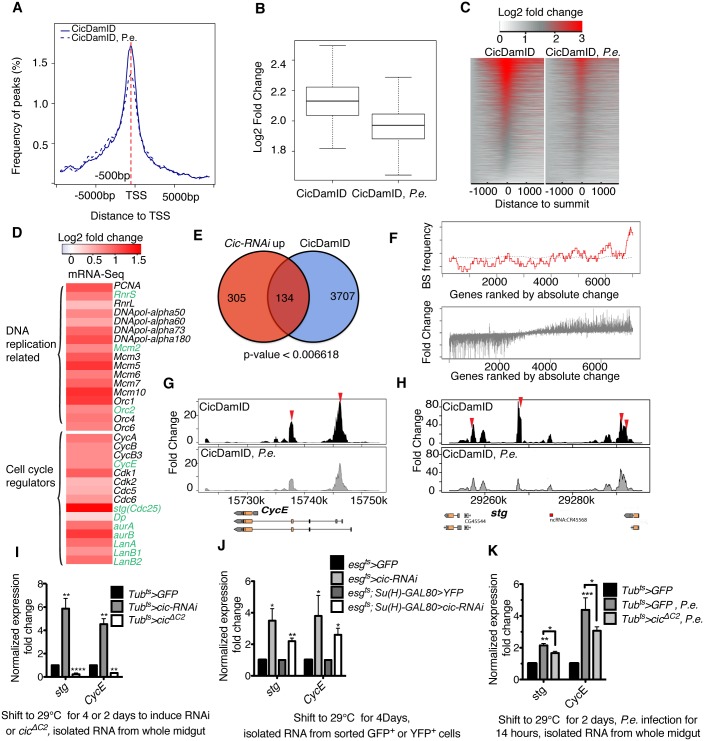
Cic targets genes in ISCs found by DamID-Seq.(A) Graph showing the location of Cic binding relative to annotated transcript TSSs. The distance is from the summit of the Cic peaks to the nearest TSS. Dashed red line showed the summit of the graph is 500bp away from TSS. (B) Box plot showing fold change of peaks in CicDamID and P.e. infected CicDam. (C) Heatmap showing fold enrichment of Cic peaks from Cic DamID-Seq without or with P.e. infection. Y axis represents genes associated with the Cic binding peaks. (D) Expression heatmap of cell cycle regulators and DNA replication related genes from RNA-Seq data from cic-RNAi expressing FACS sorted progenitor cells. The names of the genes that had Cic binding sites by DamID are written in green. (E) Venn diagram showing the overlap between genes upregulated > 1.5 fold upon cic-RNAi (left) and genes associated with Cic binding peaks (right) in ISC/EBs. (F) Graph showing correlation between genes upregulated in Cic-depleted progenitor cells, and the Cic-DamID peaks that changed significantly upon P.e. infection (upper panel). Lower panel show genes ranked by absolute expression change, and then plotted for expression fold change (bottom). (G, H) Cic binding sites in the CycE and stg loci, as determined by Cic DamID-Seq in ISC/EBs from control (above) and P.e. infected (below) midguts. Vertical bars represent the log2 ratio of the Dam-fusion signal to the Dam-only signal. Red arrows indicate TGAATG(G/A)A motifs. (I-K) mRNA level fold changes of stg and CycE analyzed by qRT-PCR and normalized to β-Tub and Rp49. (I) stg and CycE fold enrichment from whole midguts after knocking down or over expressing cic in all cells using the tub
ts
(tubGal4; tubGal80ts) driver. Transcription of both stg and CycE was induced in cic knock-down midguts and inhibitied in cic over-expressing midgut. (J) stg and CycE expression is upregulated in cic-depleted, FACS-sorted progenitor cells (ISC &EB) and ISCs. (K) stg and CycE expression fold change in cic over expressing midguts after P.e. infection. The induction of stg and CycE by P.e. infection was suppressed by cic
ΔC2 overexpression. Statistical significance was determined by Student’s t test (*p<0.05, **p<0.01, ***p<0.001, ****p<0.0001). Error bars in each graph represent standard deviations.